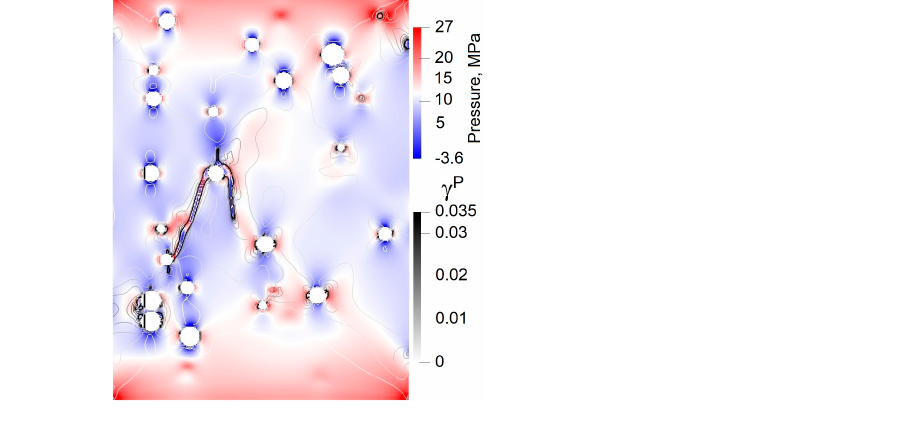
Figure 8. Combined pattern of hydrostatic pressure and inelastic strain in vertical cross-section of the model slightly prior to state (c).